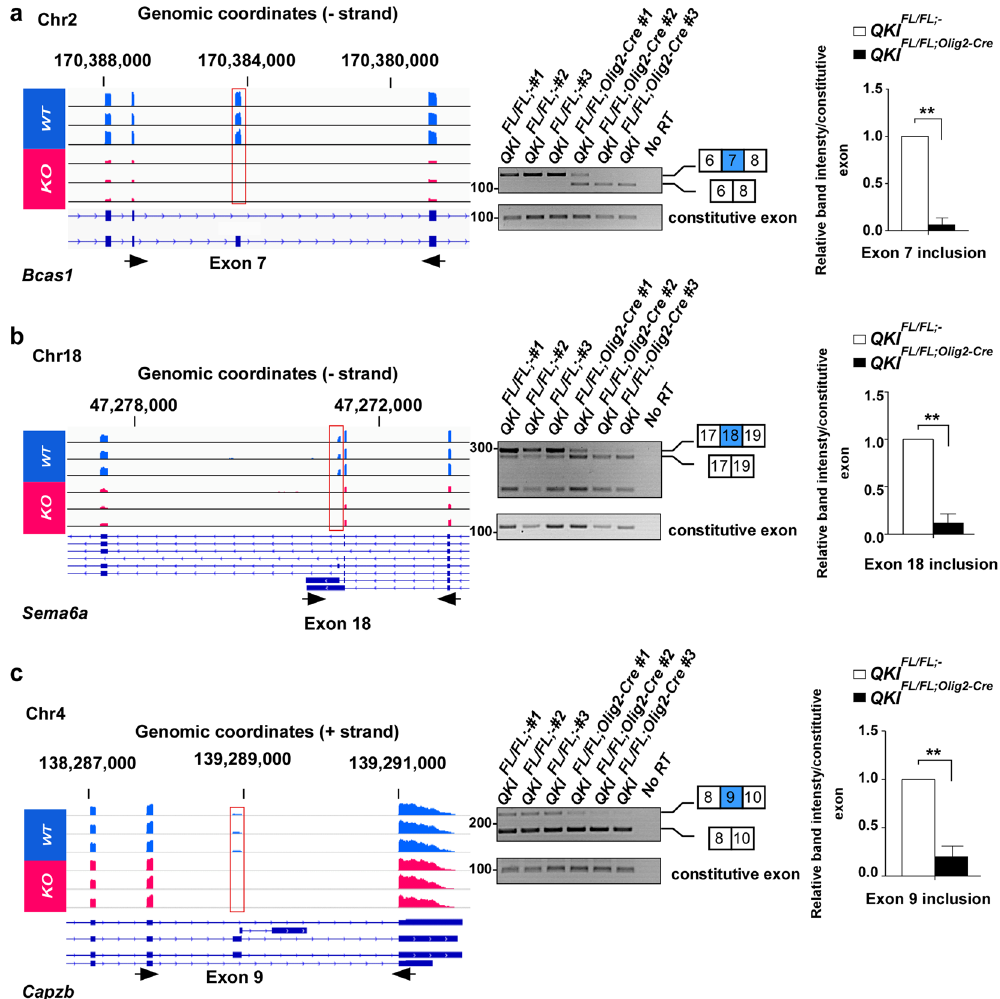
Figure 4. Alternative splicing event in Bcas1, Sema6a and Capzb in QKI FL / FL ; Olig2 - Cre and QKI FL / FL ;- mice. ( a , b , c ) Left: IGV views of the exon skipping events in Bcas1 , Sema6a and Capzb . All samples are represented on the same scale for each screenshot. Black arrows represent the primers used for validation by RT-PCR. Right: Validation of exon skipping events by semi-quantitative PCR in n = 3 mice per genotype. The constitutive exon is present in all isoforms of the gene and is not alternatively spliced. The pixel densities of PCR bands from 3 independent mice brain RNA samples were quantified using ImageJ software, normalized over wild-type mice and represented as mean ± SEM (Student t -test, ** p <